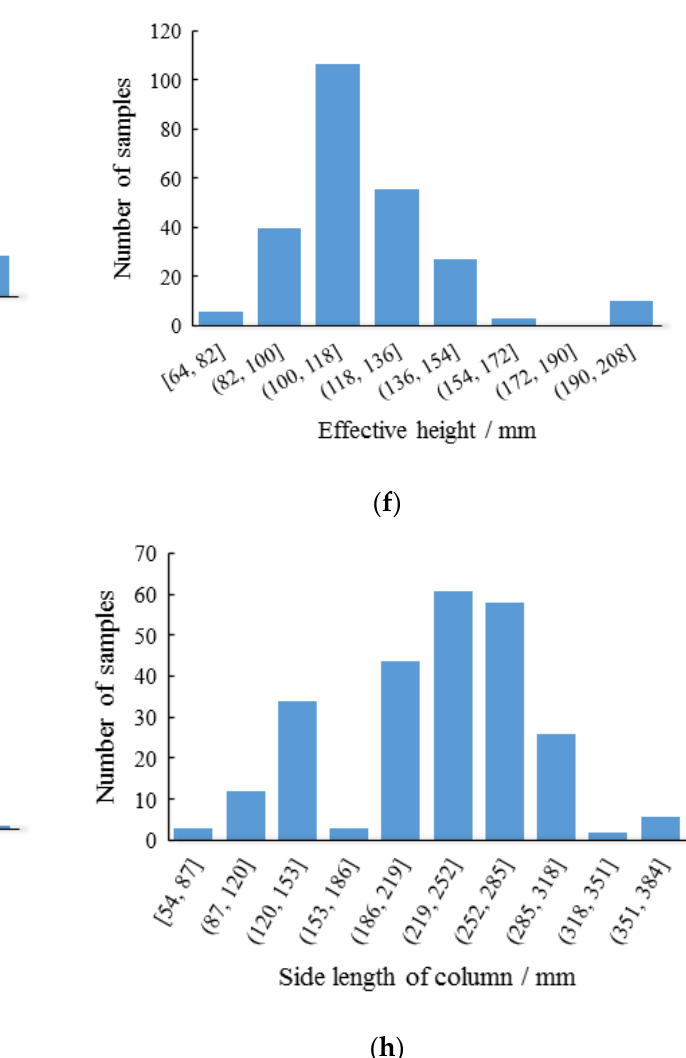
Figure 2. Distribution of specimens: ( a ) Side length of the slab; ( b ) Test punching resistance capacity; ( c ) Yield strength of reinforcement; ( d ) Compressive strength of concrete; ( e ) Reinforcement ratio; ( f ) Effective height; ( g ) Axial tensile strength of concrete; ( h ) Side length of column.